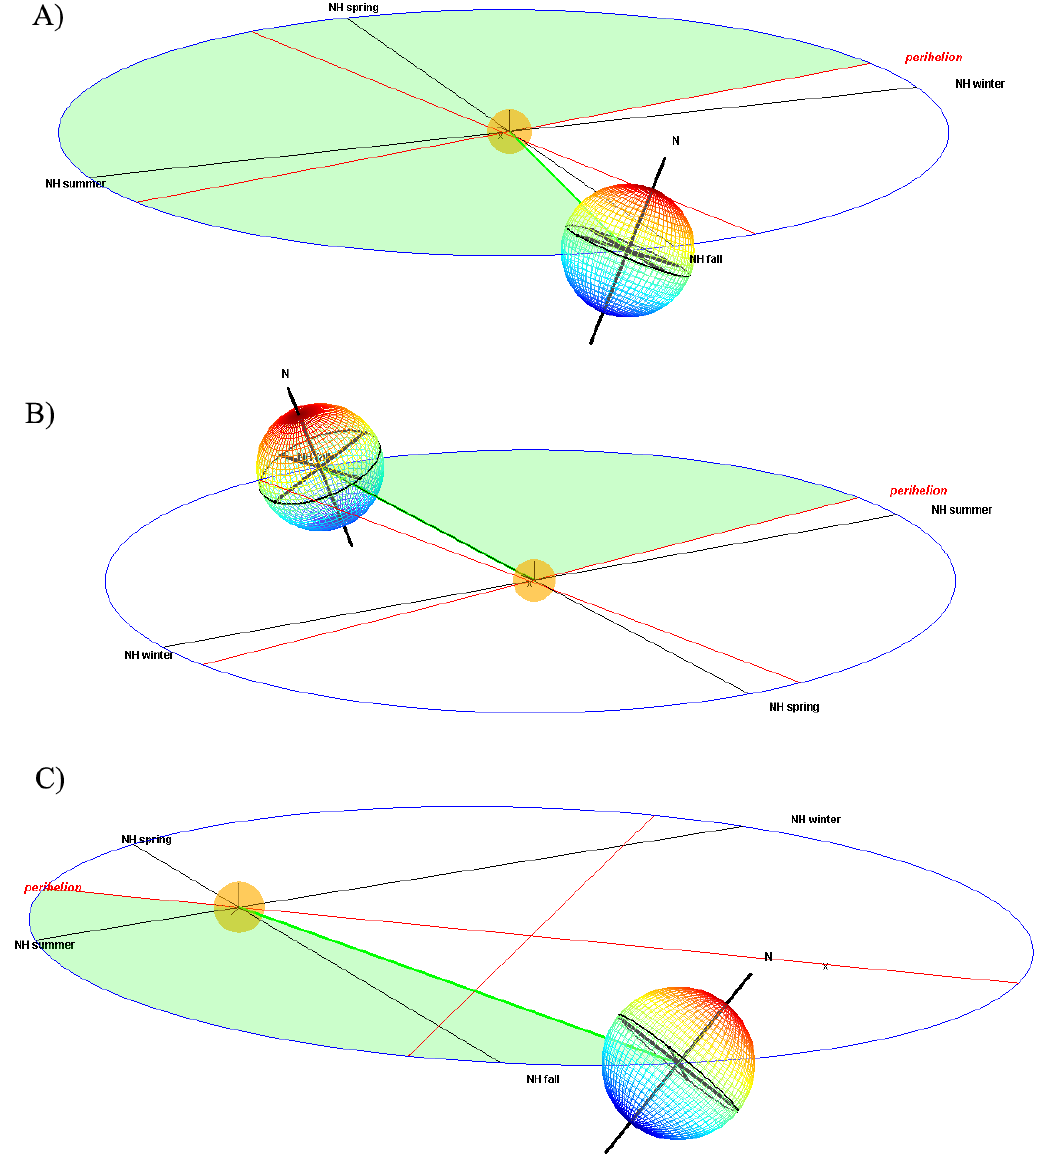
Figure 2. (A) Present (J2000) orbital configuration for 16 September, using the La2004 solution and the calendar start date fixed at vernal equinox on 20 March. The orbital ellipse is shown in blue, the semi-major and semi-minor axes (perpendicular to each other) are in red and the lines connecting the solstices and equinoxes (also perpendicular to each other) are shown in black. The perihelion point, as well as the equinoxes and solstices are labeled (NH=Northern Hemisphere). The Sun is shown as a semi-transparent yellowish sphere centered at one of the orbital ellipse’s foci, both of which are marked with an “x” along the semi-major axis. The Earth is plotted with its center on the corresponding place along the orbit, and the angle it has swept since last perihelion passage (the true anomaly angle) is filled in semi- transparent light green. Earth’s Equator is plotted as a solid black line, and its axis of rotation is plotted as a dotted black line , with the North Pole marked. The spheres of the Earth and the Sun are not to scale, the rest of the figure is geometrically/astronomically accurate and to scale. This plot is in 3-D and has pan–tilt–zoom capability in the Earth Orbit v2.1 model. The corresponding GUI with numerical ancillary output is shown in Fig. 1 (for latitude 43 ◦ N and S o = 1366Wm − 2 ) . (B) Real orbital configuration for 16 September, 10kyr in the future, using the La2004 solution and a 20 March equinox as calendar start date. (C) Demo (imaginary) orbital configuration for 1 July (vernal equinox fixed at 20 March), eccentricity=0.6, obliquity=45 ◦ , longitude of perihelion=225 ◦ . The geometry is consistent with Berger et al. (2010), their Fig. 1, although it is being viewed in (A) and (C) from the direction of fall equinox, as opposed to from the direction of vernal equinox in their figure. The apparent eccentricity of the three orbits in Fig. 2 is also due to the view angle of the 3-D plot and the respective projection onto a 2-D monitor/paper; the intrinsic eccentricity can be judged by tilting the plot or observing the relative distance from the two foci (the Sun being at one of them) to the center of the ellipse, the intersection of the semi-major and semi-minor axes (red